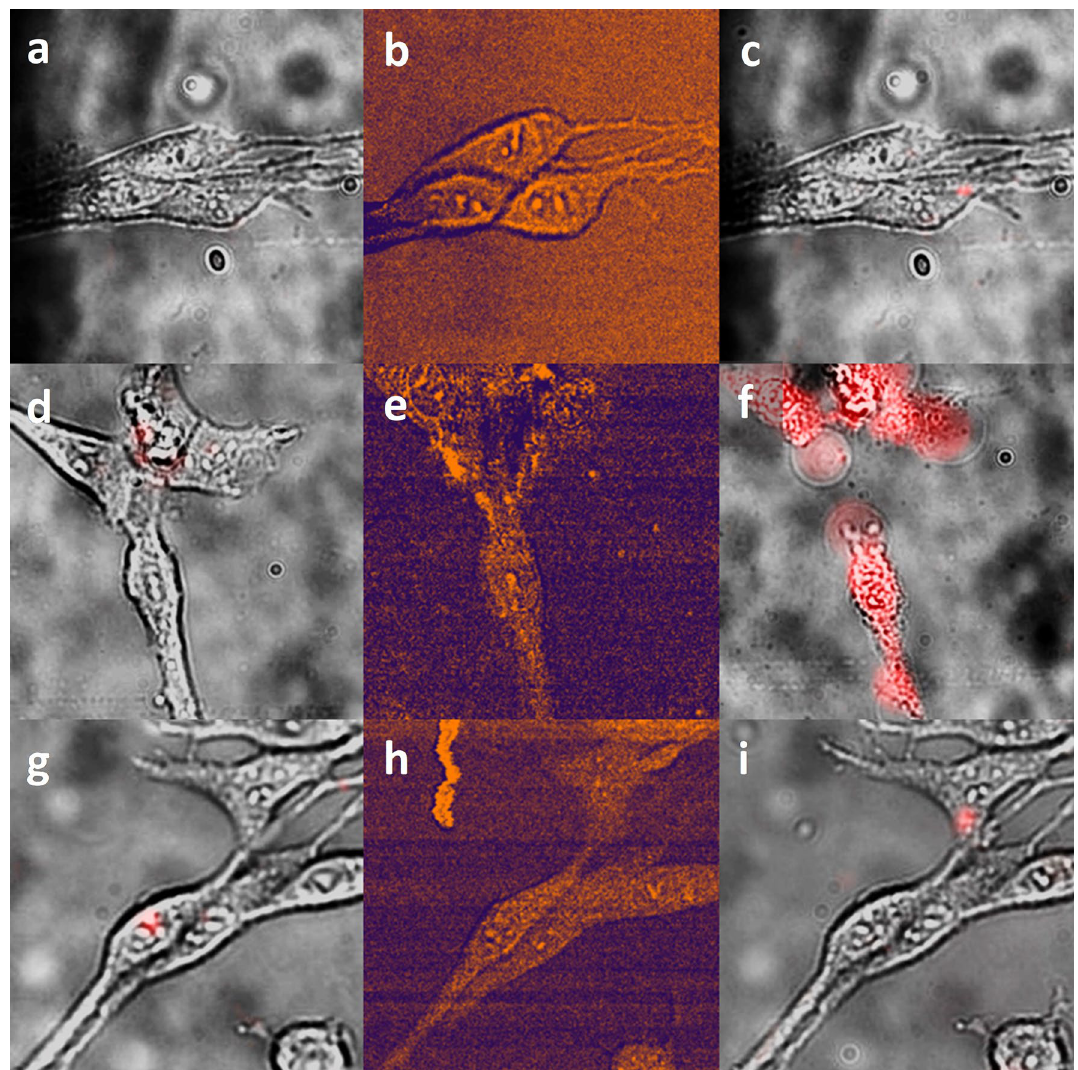
Figure 3. Photo-induced SWCNT-mediated destruction of glioma cells by NIR pico-second pulsed irradiation. ( a – c ) Bare C6 glioma cells; ( d – f ) C6 glioma cells with accumulated micron-sized SWCNT agglomerates, ( g – i ) C6 glioma cells in the presence of the SWCNTs suspension in the extracellular medium. ( a , d , g ) bright-field images superimposed with PI fluorescence images before irradiation; ( b , e , h ) CARS images; ( c , f , i ) bright-field images superimposed with PI fluorescence images after irradiation with 10 ps laser pulses (910.5/1064 nm, 10 6 W/cm 2 ) for 7